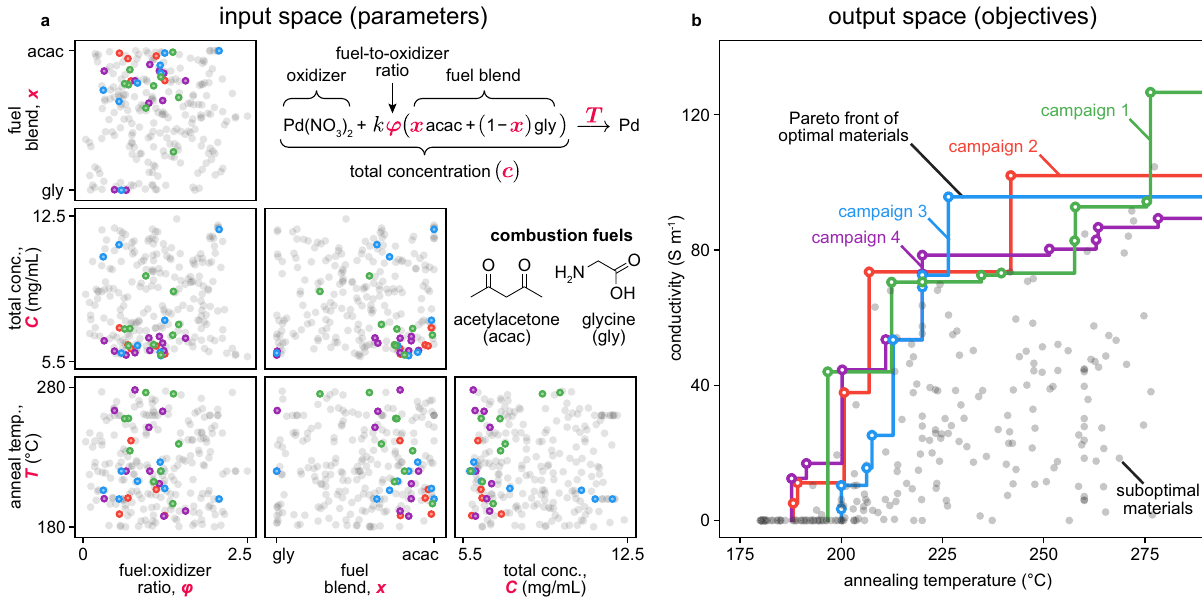
Fig. 3 Trade-off between annealing temperature and conductivity for the combustion synthesized palladium fi lms. a Maps of the combustion synthesis conditions required to obtain experimental outcomes on the Pareto front. Sampled points not on the Pareto front are shown in gray. The combustion synthesis reaction, with parameters manipulated during the optimization highlighted, is shown. In this reaction x controls the fuel blend and φ is the fuel-to- oxidizer ratio, as calculated using Jain ’ s method (see Supplementary Methods). The fuel-to-oxidizer ratio used is scaled by k = 36/5(8 - 5 x ) to account for the differing reducing valences of the acetylacetone and glycine fuels. b The empirical Pareto fronts from each of the four campaigns (solid lines) reveal the observed trade-off between temperature and conductivity. The experimental points which de fi ne the fronts are shown with open markers. Sampled points not on the Pareto front are shown in